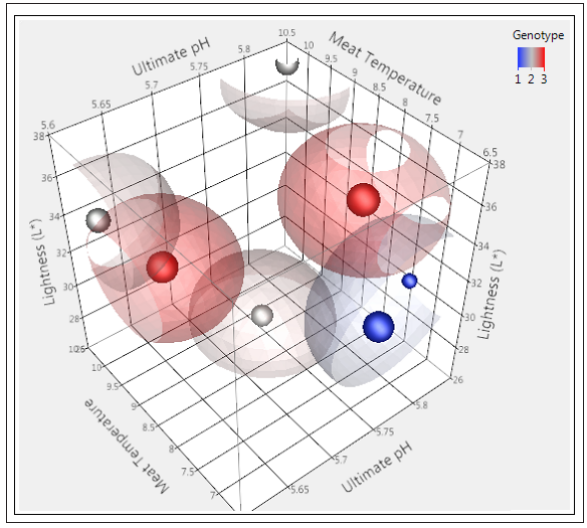
The first three principal components of beef Muscularis longis- simus thoracis et lumborum muscle from cows for meat attri- butes related to meat quality. As observed in Table 5, pH is the primary attribute that controls the u outcome of the other meat quality attributes. This implies that when considering the improvement of beef, one has to make sure that the factors that influence pH are minimised as far as possible. In agreement with this study, reports by Li et al . 53 , Vimiso and Muchenje 55 and Scholtz 68 indicated that pH was the major factor in meat quality and the extent of u protein denaturation. In addition, the amount of protein in the muscles was negatively affected by reduced metmyoglobin which affected the water-holding capacity and colour stability of the muscle. 61,69 This finding is in agreement with reports by Xia et al . 9 in which the variation of the pigment and oxidation state led to differences in the L* and a*